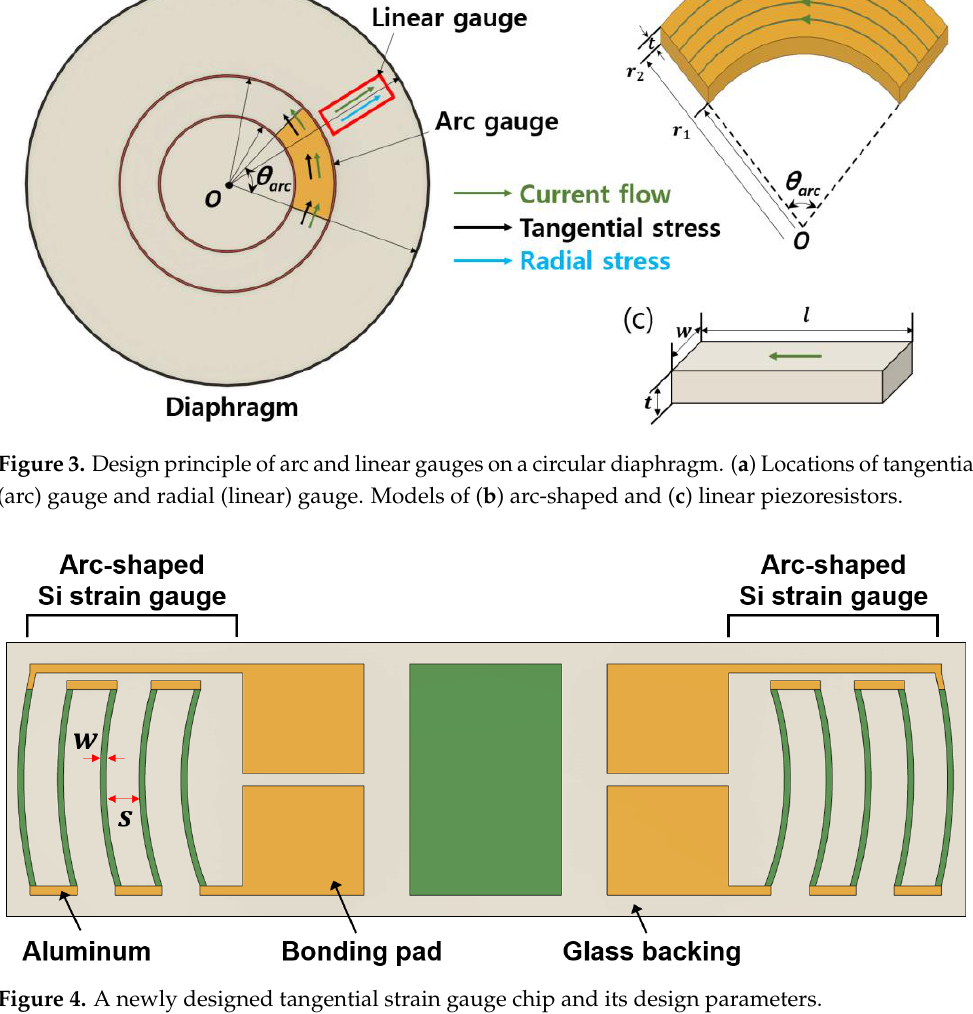
Figure 3. Design principle of arc and linear gauges on a circular diaphragm. ( a ) Locations of tangen-